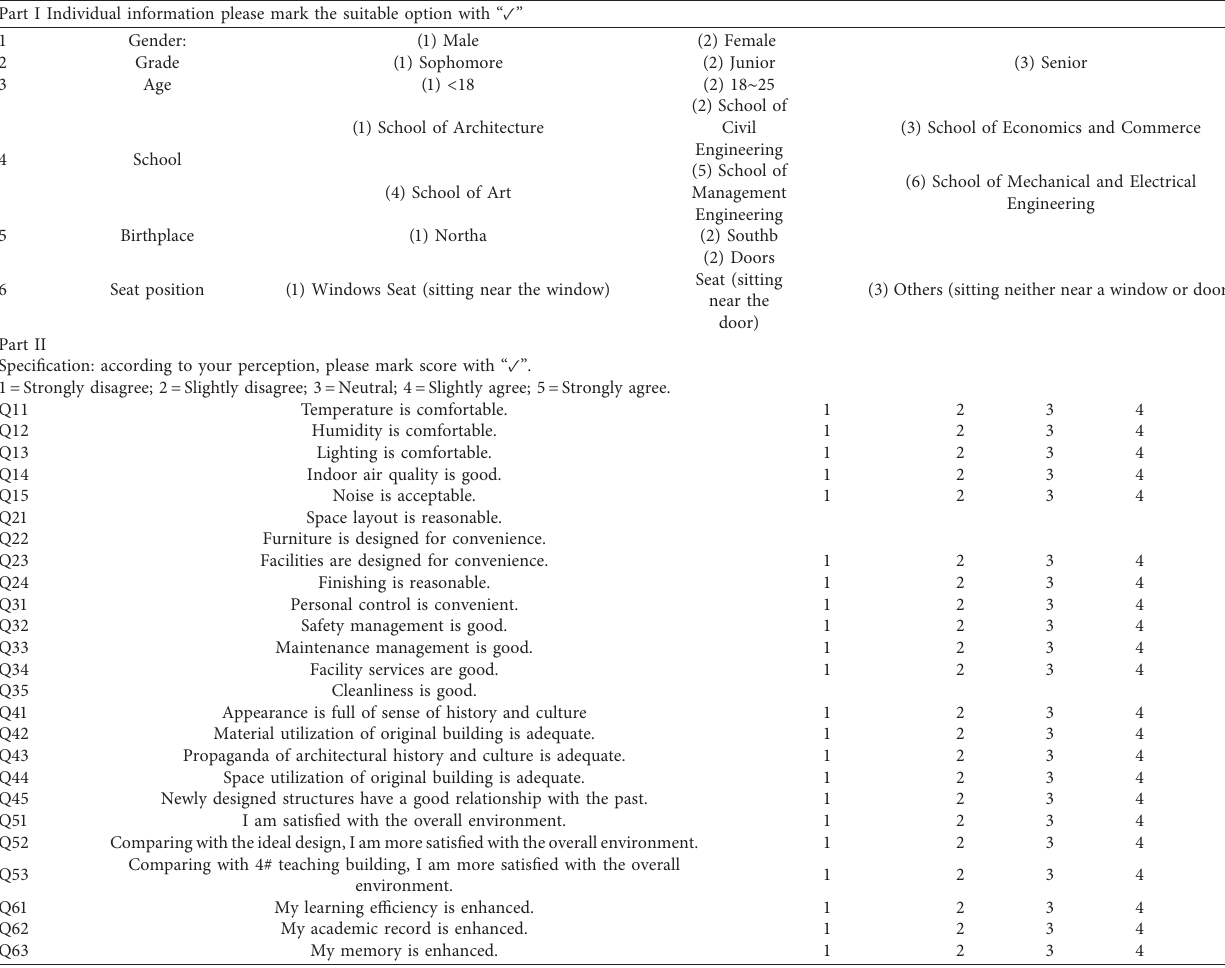
Table 2: The questionnaire of students perception towards performance of teaching building.